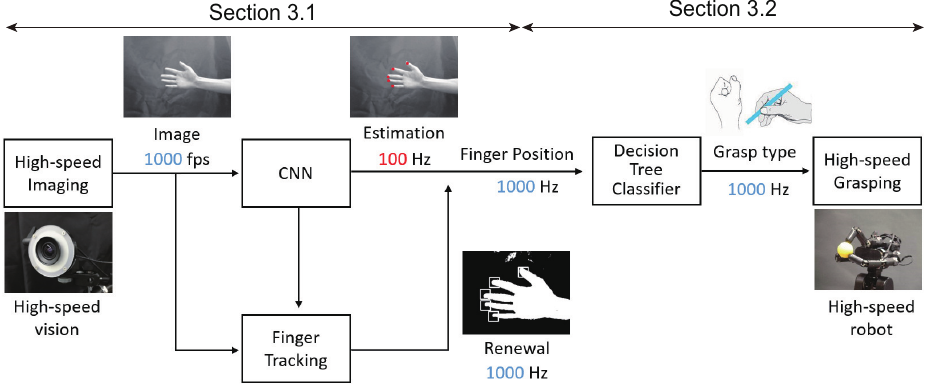
Figure 2. Overall flow of the proposed teleoperation